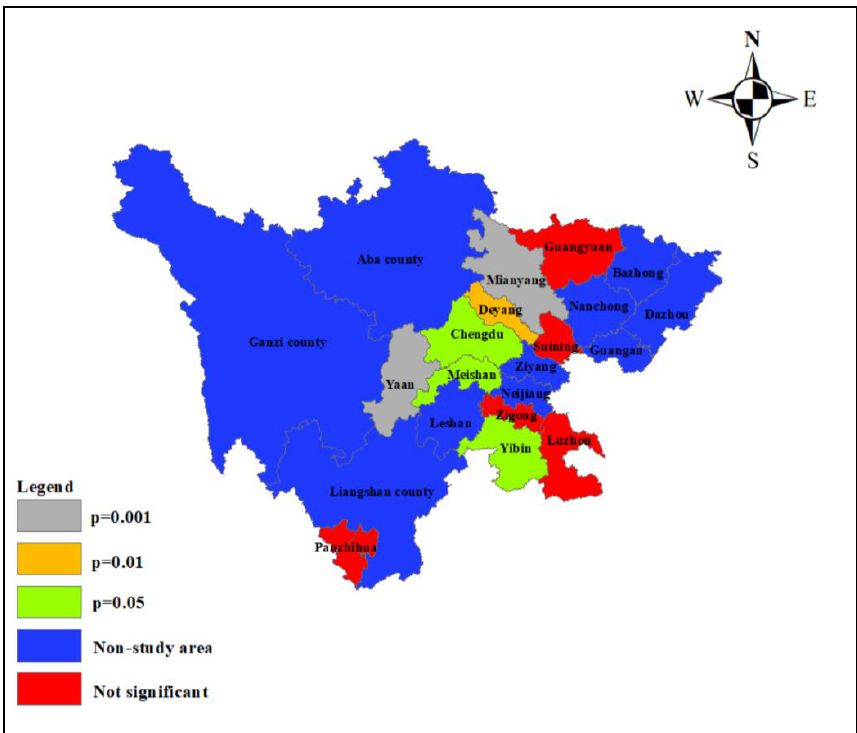
Figure 17. Reliability of local Moran’s I statistic calculation results in 2020.